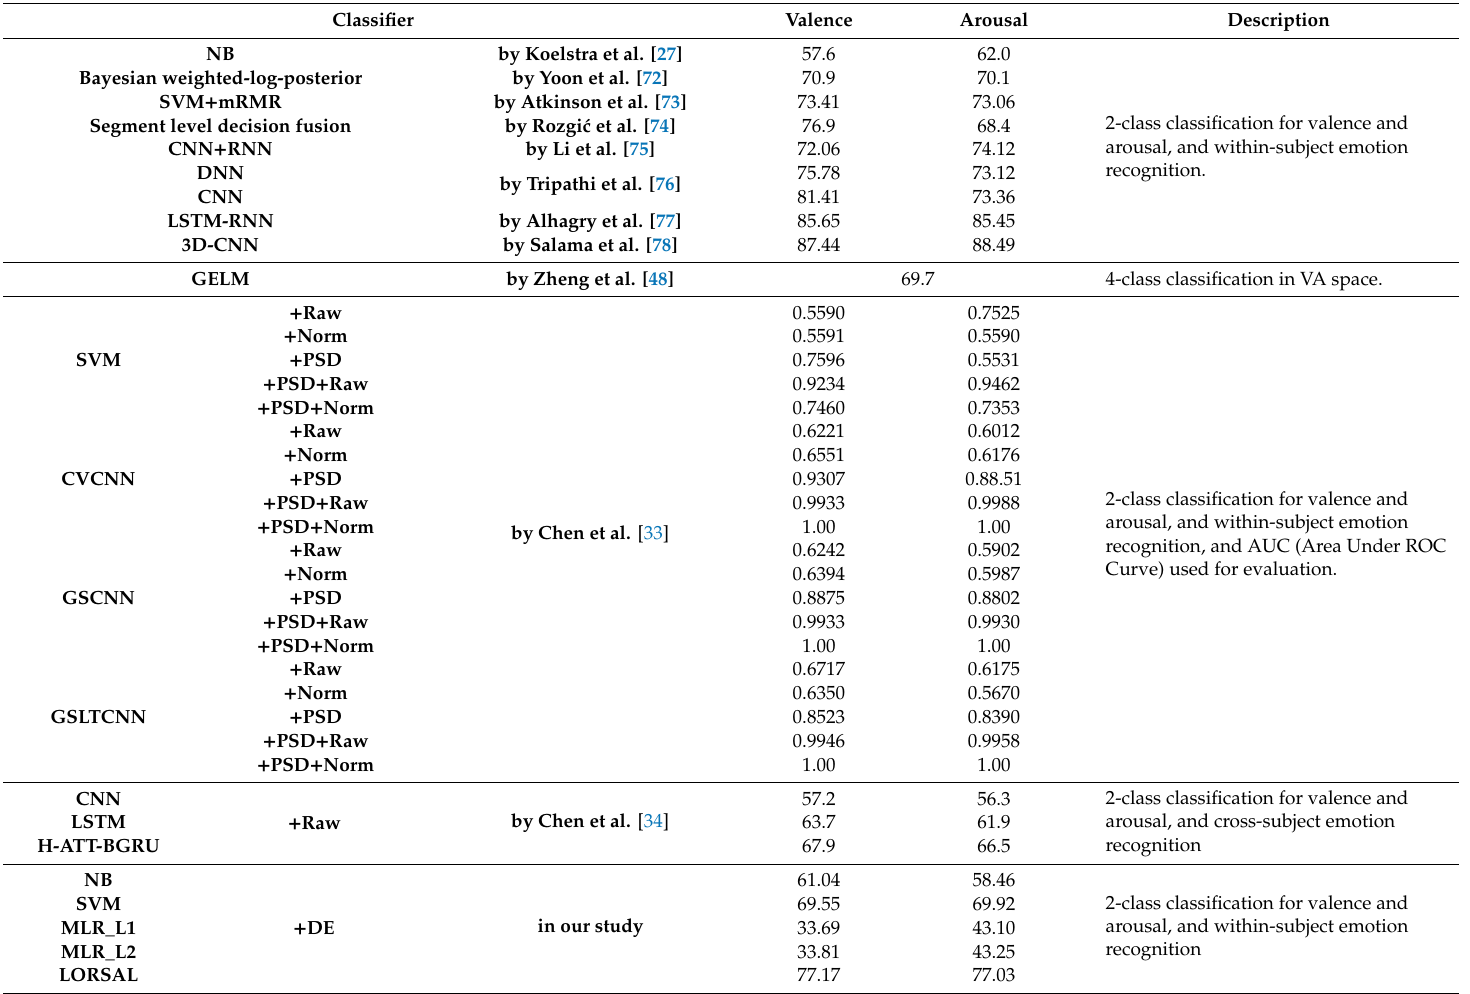
Table 5. Comparison of the introduced LORSAL methods, the other shallow classifiers, and the deep learning approaches for EEG-based emotion recognition of LV / HV and LA / HA on DEAP